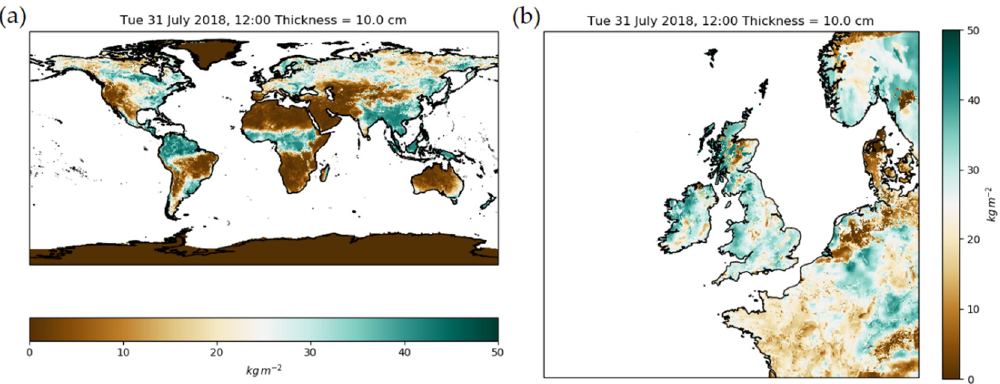
Figure 1. Soil moisture in the first 10 cm of soil for the ( a ) global and ( b ) UKV. Surface soil moisture analysis produced by the operational global (N1280) and regional experiment LSDA-O (UKV) LSDA systems for the first soil layer (10 cm thickness) on 31 July, 2018 12Z. Units are soil moisture content [kg/m2].